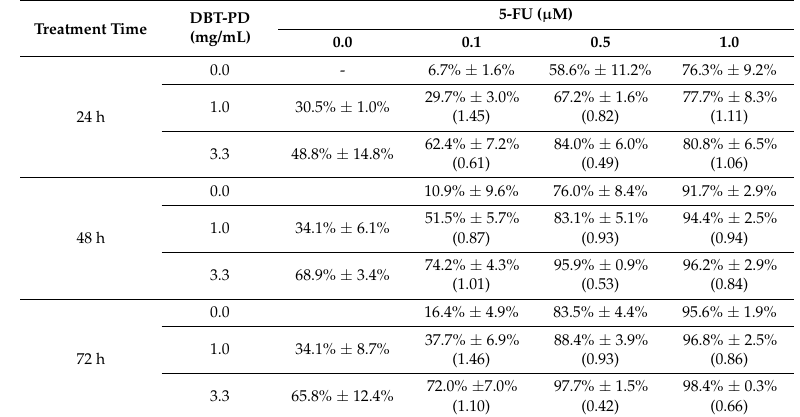
Table 4. Percent growth inhibition and combination index (CI) of CT26 cells treated with DBT-PD and different concentrations of